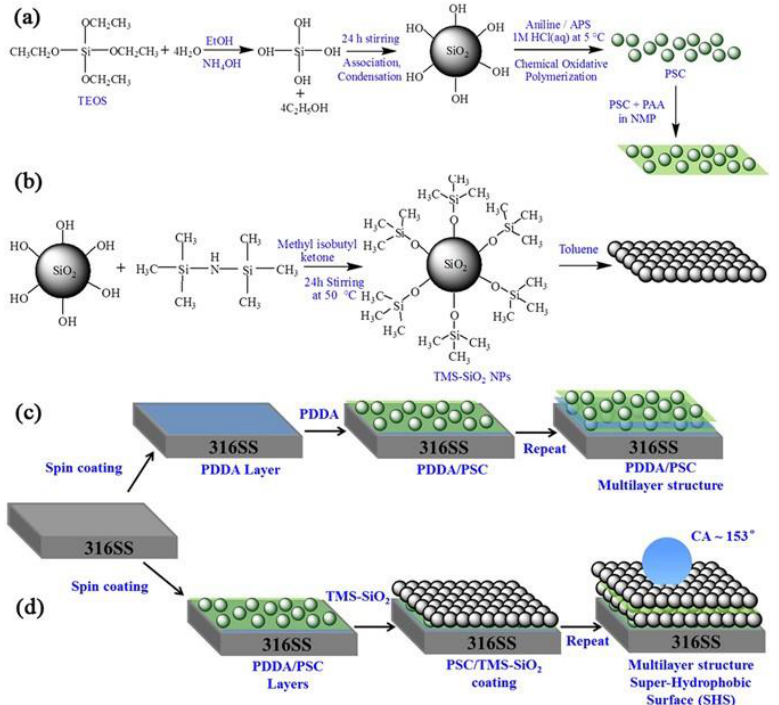
Figure 16. Schematic illustration of the synthesis of ( a ) PSC composite and preparation of its coating solution, ( b ) surface modification of silica to obtain TMS-SiO 2 NPs. Fabrication of ( c ) PDDA/PSC and ( d ) PSC/TMS-SiO 2 multilayers on 316SS by spin coating. Reproduced with permission from [116].